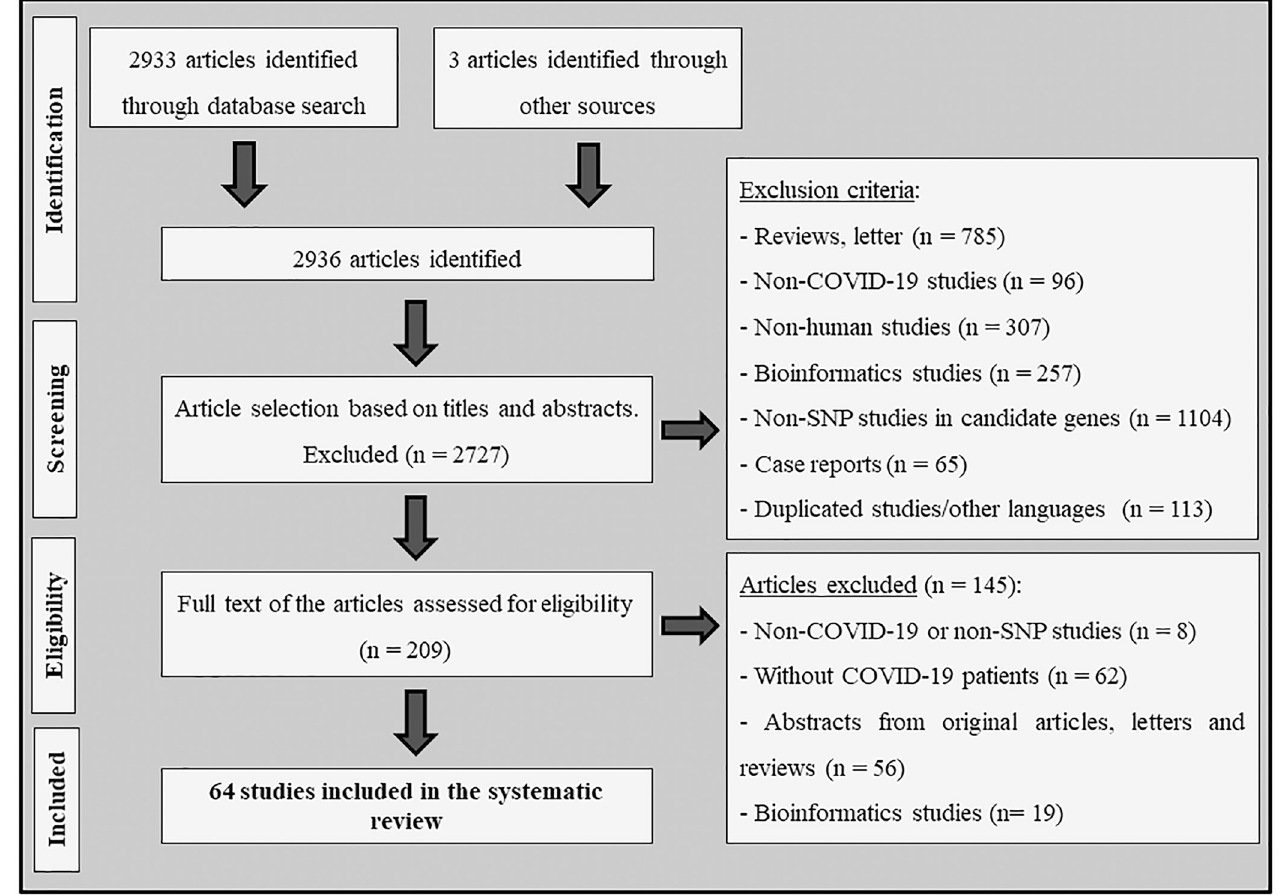
Fig 1. Flowchart illustrating the search strategy used to identify association studies between genetic polymorphisms and COVID-19 disease.